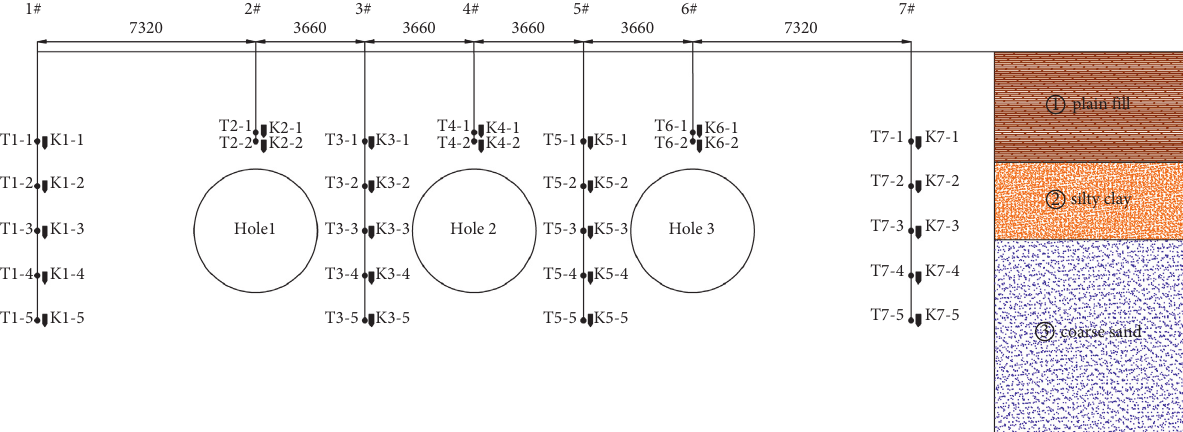
Figure 7: Distribution map of monitoring points.